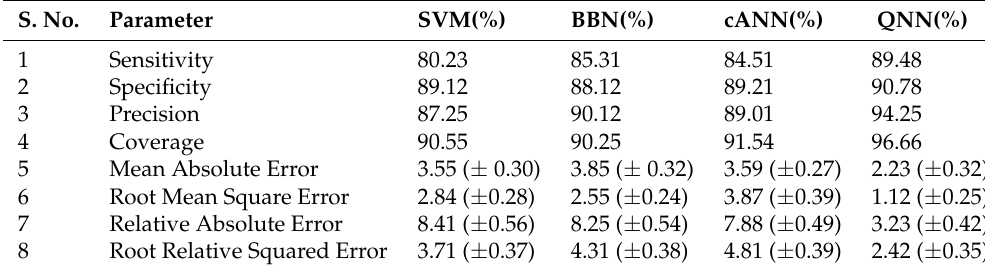
Table 6. Statistical Results for Prediction